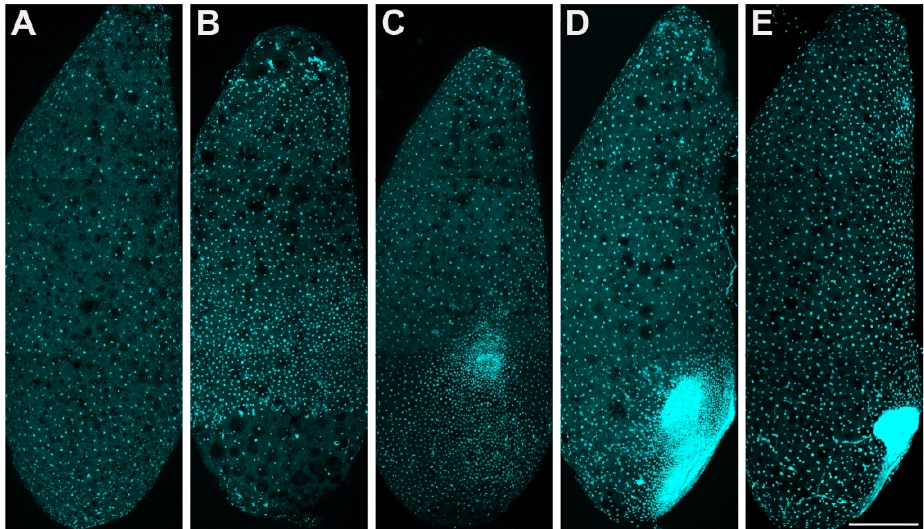
Figure 2. P. americana embryos in stage 1 and stage 2. Lateral views, ventral to the right. ( A , B ) Syncytial blastocyst stage. ( A ) Early-stage 1, approximately 24 h. ( B ) Late-stage 1, approximately 48 h. ( C – E ) Stage 2, the formation of the embryo. ( C ) Early-stage 2, approximately 72 h. ( D ) Middle stage 2, approximately 84 h. ( E ) Late-stage 2, approximately 96 h. Scale bars: 500 μ m. Schemes follow the same formatting.